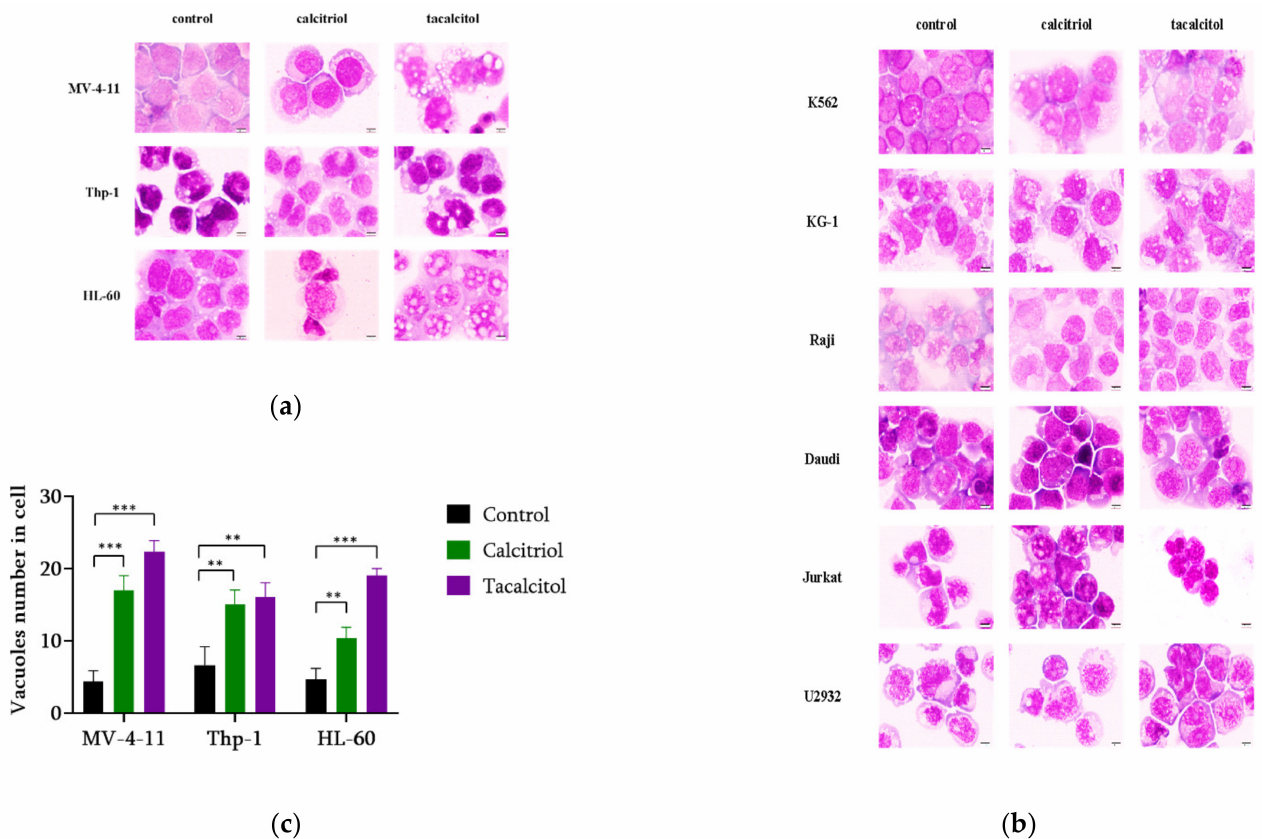
Figure 2. Human leukemia cells. Sensitive to calcitriol and tacalcitol MV-4-11, Thp-1, and HL-60 cells showed changes in cell morphology and numbers of vacuoles ( a , b ). Other lymphoma and leukemia cells were insensitive to calcitriol and tacalcitol. There were no changes in the morphology of these cells ( c ). May–Grunwald, Giemsa staining (the scale corresponds to 5 µ m). Vacuole numbers (mean ± standard deviation). ** p <0.05 *** p <0.01 statistical significance to the